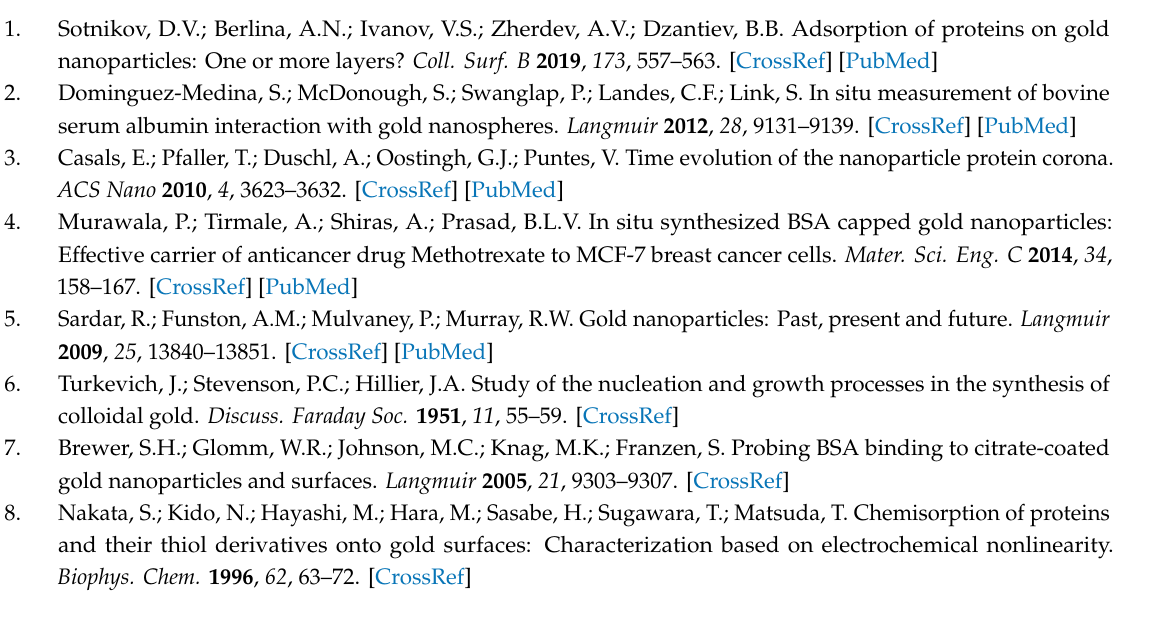
Figure S1: TEM images of gold nanoparticles formed in BSA evidencing the presence of various shapes. Figure S2: TEM images of gold nanoparticles formed in BSA after three weeks. Figure S3: TEM image of AuNPs with smaller particle size (roughly 5 nm) formed after adding a new quantity of Au(III). Figure S4: Simulated EPR spectra of CAT16 in (A) BSA (10 mg / mL), (B) BSA / AuNPs after 10 days and (C) BSA / AuNPs after 17 days. Table S1: EPR parameters obtained by spectral